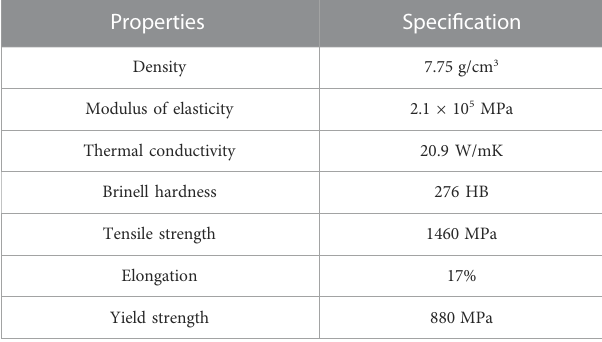
TABLE 2 Mechanical properties of 1Cr17Ni2 at room temperature.